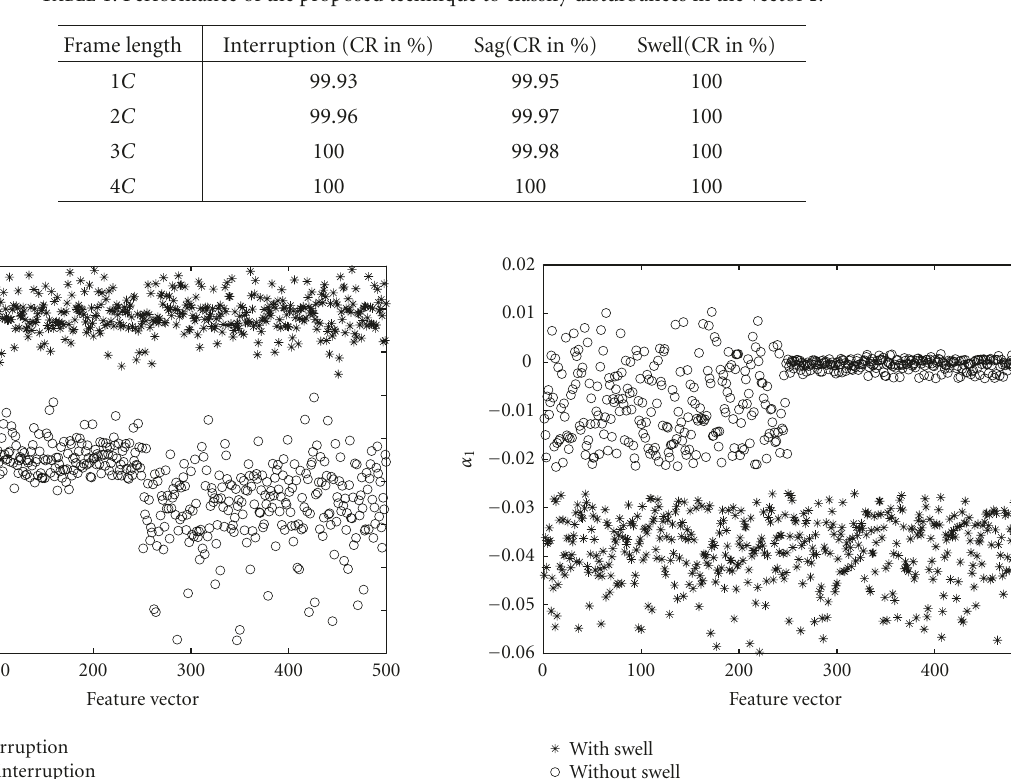
are reported when N ≥ 1024 or, at least, 4 cycles of the fun- damental component, see [3, 5, 28, 32].